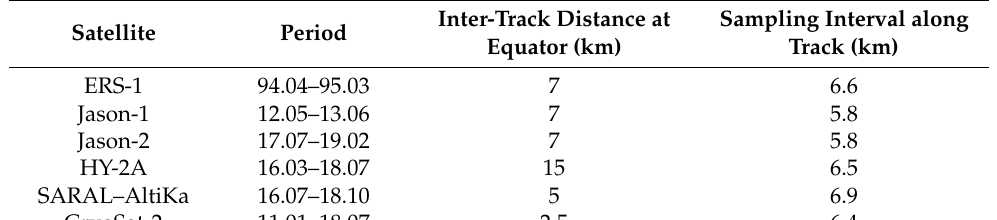
Table 2. Information on altimetric data of geodetic missions (GMs).